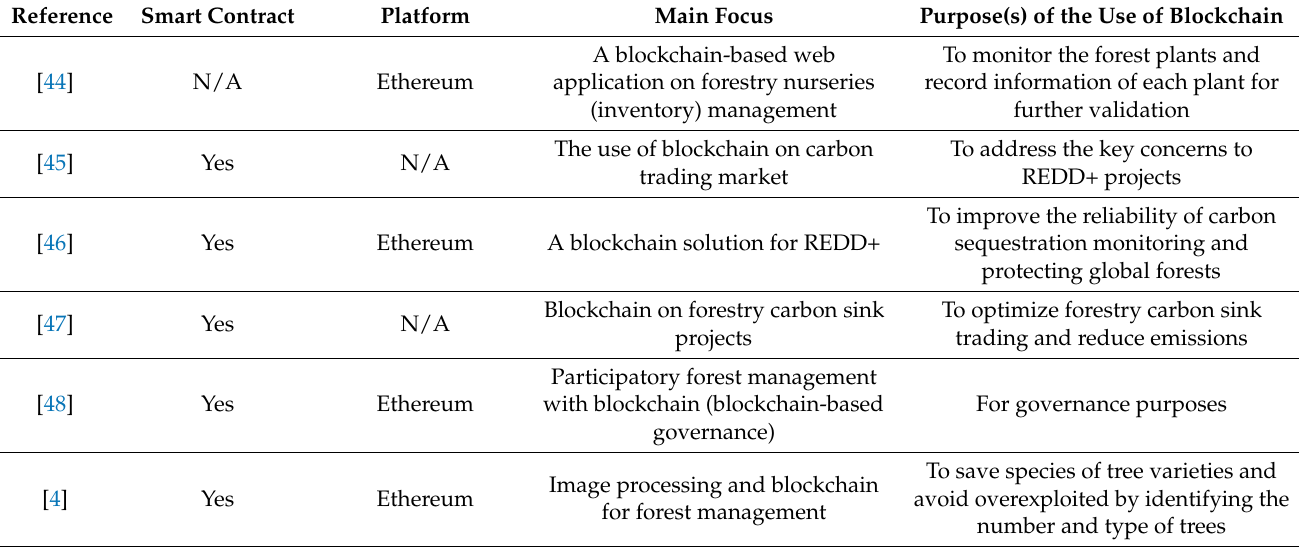
Table 3. Blockchain-based applications in forest